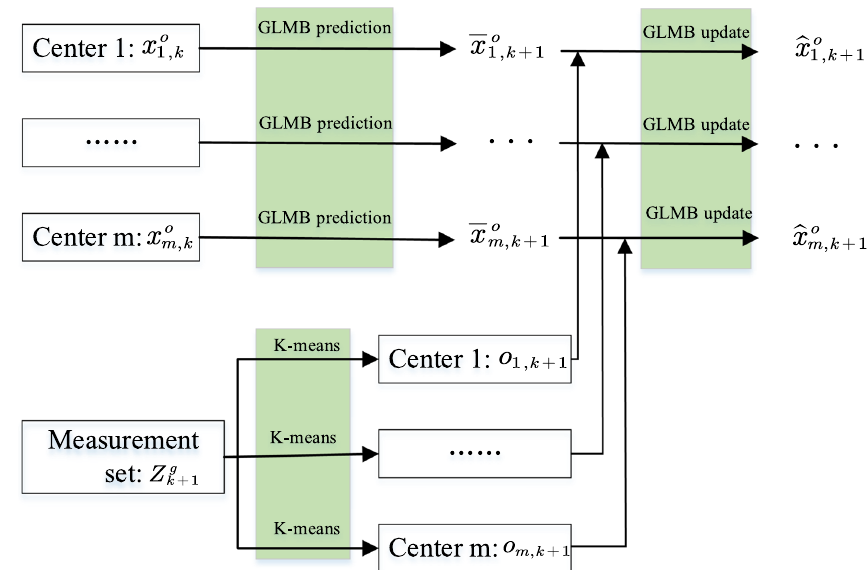
Fig. 6 Tracking of subgroup centers based on k -means clustering and